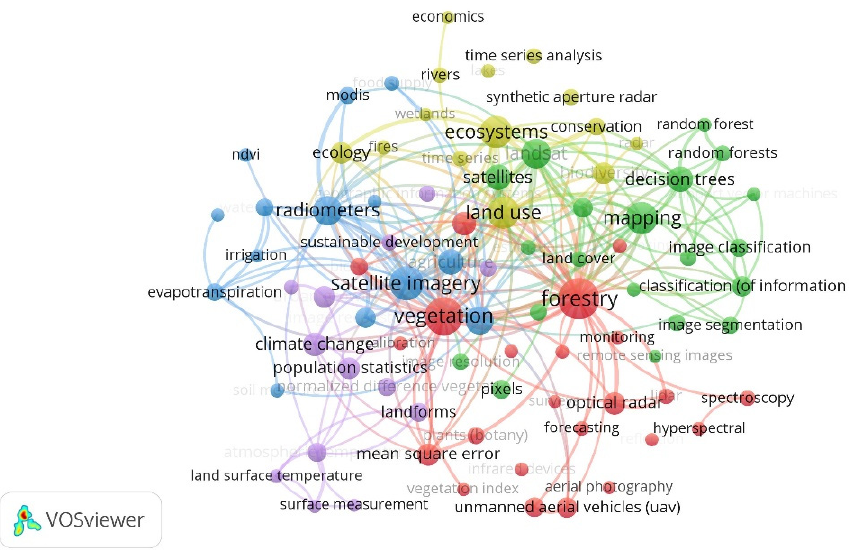
Figure 5. VOSviewer results of co-occurrences in papers published in Remote Sensing 2009–2018 with key terms “sustain” or “sustainable development”: see Appendix A.2 for details.